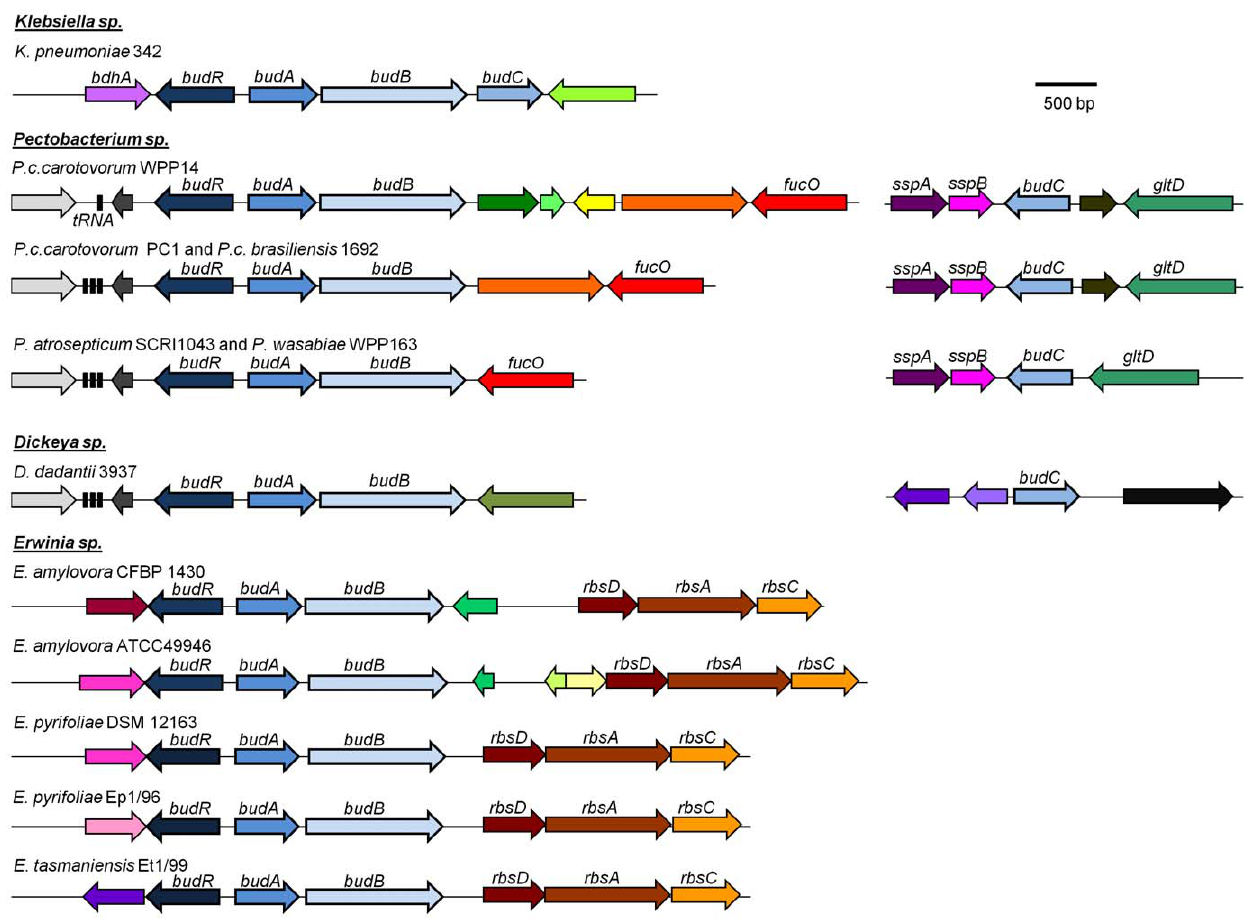
Figure 2. Operon structure of bud genes in Klebsiella , Pectobacterium , Dickeya , and Erwinia species. Sequences were retrieved from ASAP [66]. Genes are indicated by arrows, with the direction of the arrowhead indicating the direction of the gene. Genes shaded with the same color are homologous and unlabeled genes have no known function. budA is an alpha-acetolactate decarboxylase, budB is an acetolactate synthase, budC is an acetoin reductase and budR is a LysR-family transcriptional regulator. In Klebsiella and Enterobacter (not shown), budABC are in one operon. The locus of the budC gene is found elsewhere in the chromosome in Pectobacterium and Dickeya . The Erwinia species lack budC .